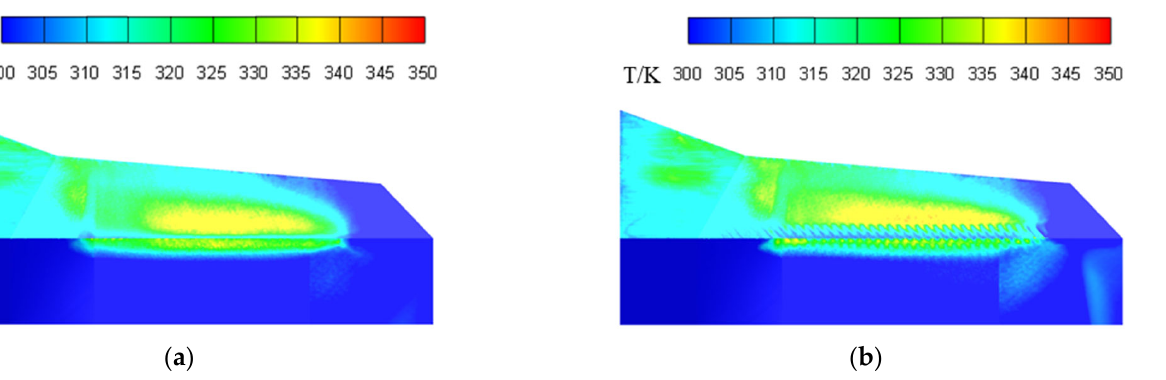
Figure 22. Surface temperature distribution on the left rear fuselage. ( a ) Model Ⅰ ; and ( b ) Model Ⅱ .